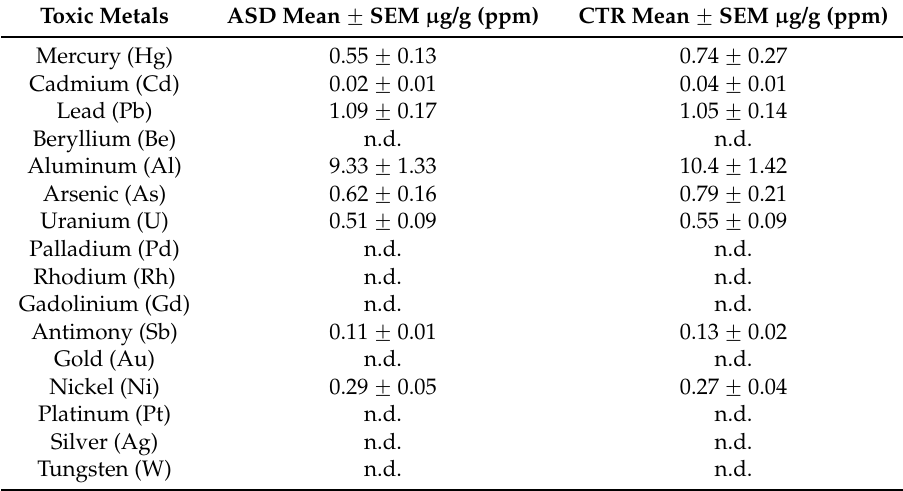
Table 2. Toxic metals in hair of ASD and CTR children.